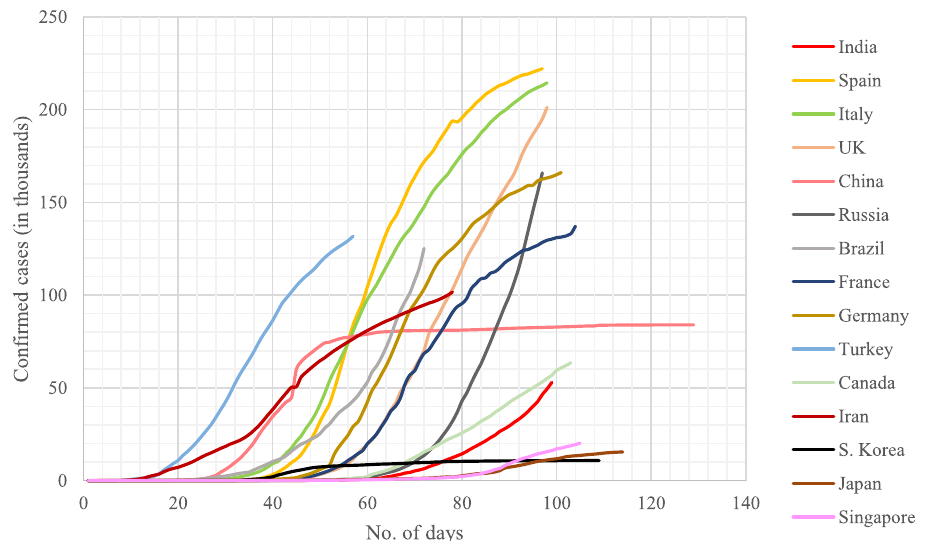
Fig. 2. Plots of confirmed cases against number of days since first reported case for different